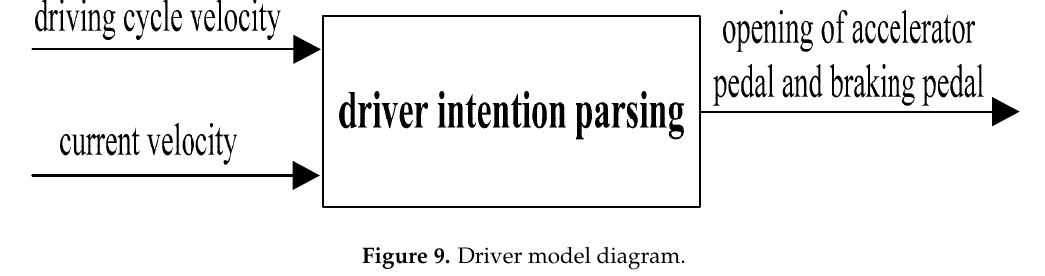
Figure 9. Driver model diagram.